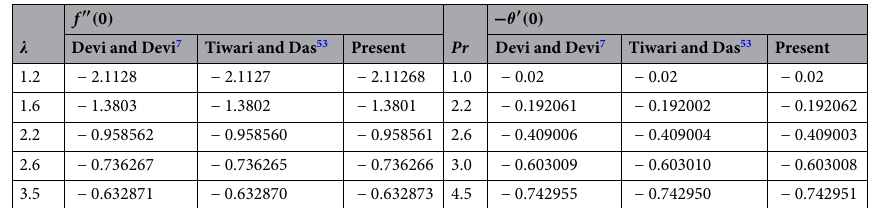
0 ) for published data for numerous φ 2 = =